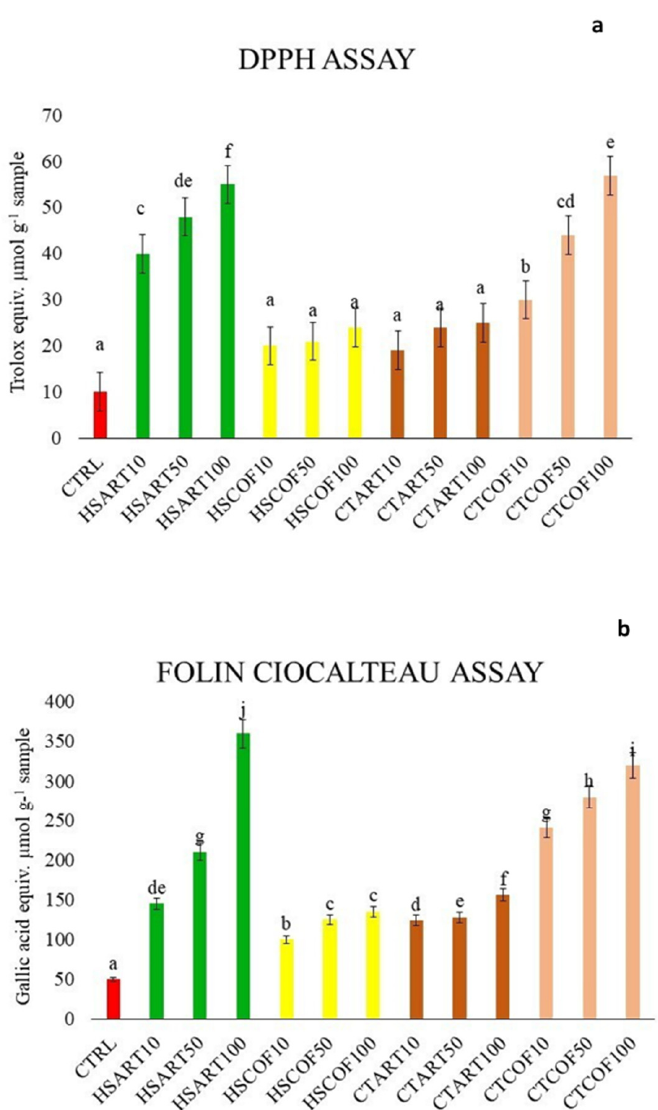
Figure 3. Antioxidant capacity ( a ) and Total Phenolic Content ( b ) of basil leaves from plants treated with humic substances (HS) and compost teas (CTs) extracted from artichoke and coffee composted vegetable wastes at different concentration (10–50–100 g L − 1 ). The different colors are associated to organic treatments applied (CTRL-red; HS-ART-green; HS-COF yellow; CT-ART-brown; CT-COF orange). Vertical bars represent the standard deviation of the mean. Columns (mean ± S.D.) followed by different letters indicate significant difference according to LSD test ( p ≤ 0.05).